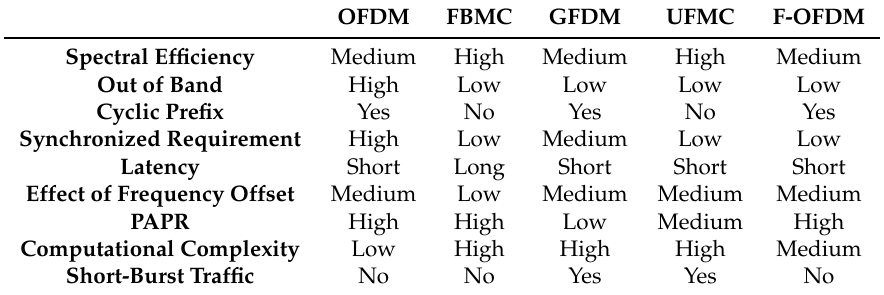
Table 6. Respective characteristics and applicability of different multicarrier modulation waveforms.